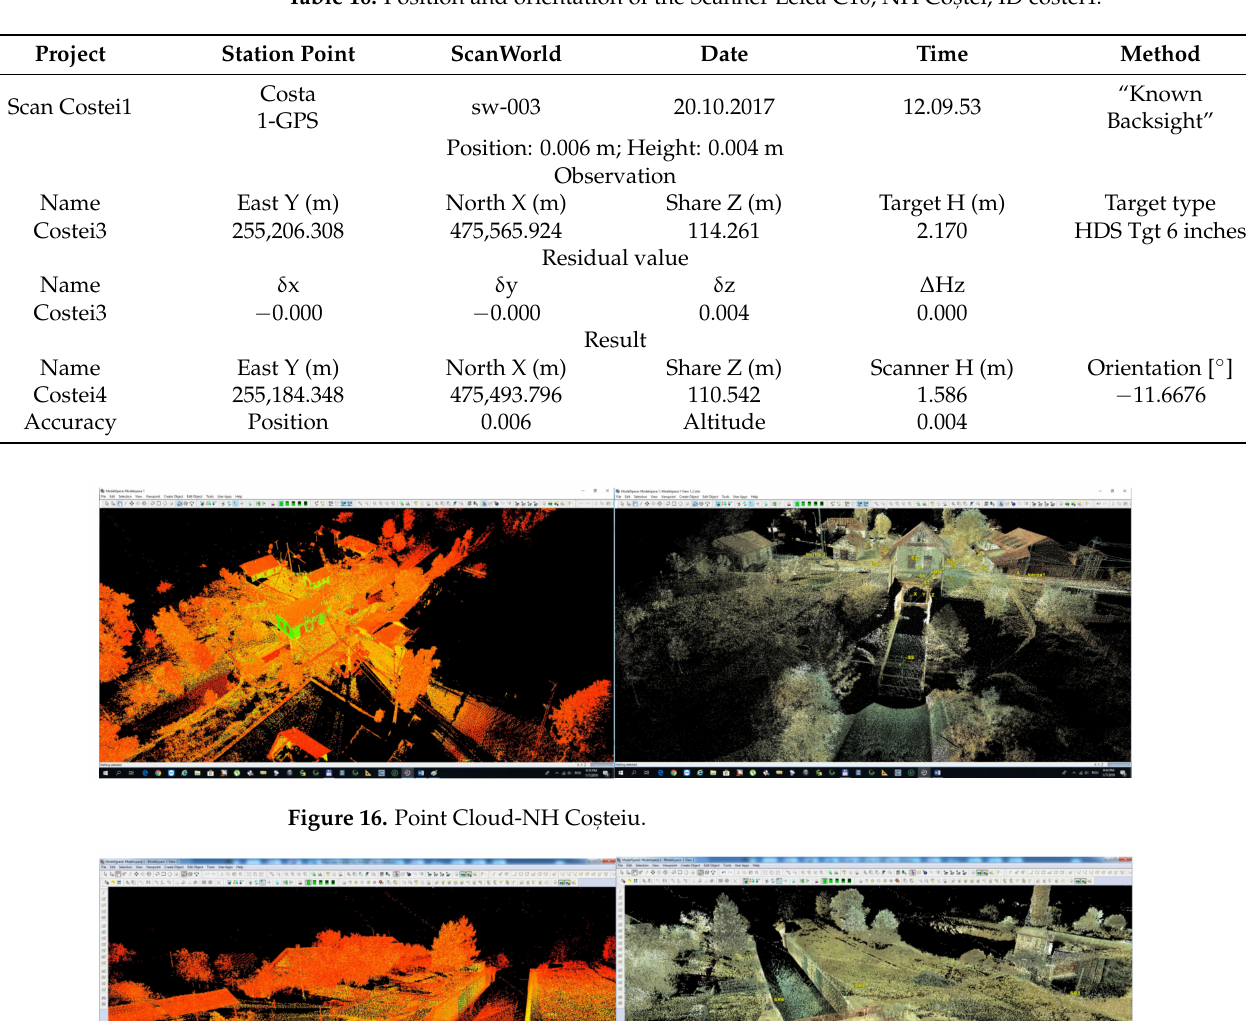
Table 16. Position and orientation of the Scanner Leica C10, NH Cos